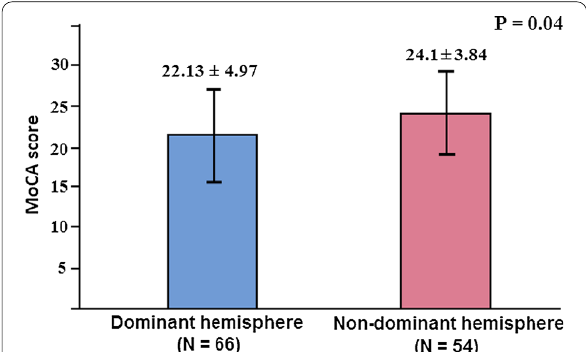
Fig. 3 Correlation of the site of lesion with the domain of cognitive decline